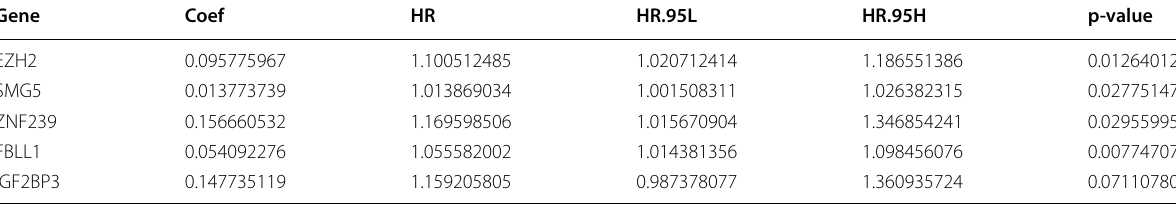
Table 2 The regression coefficient of five candidate RBPs genes Gene